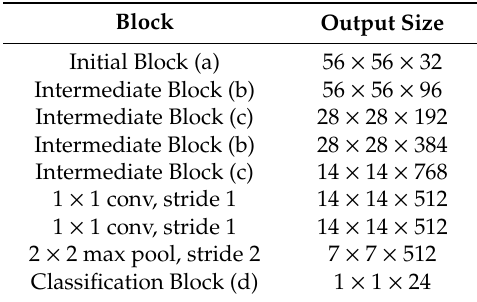
Algorithm 1. Learning Rate Schedule